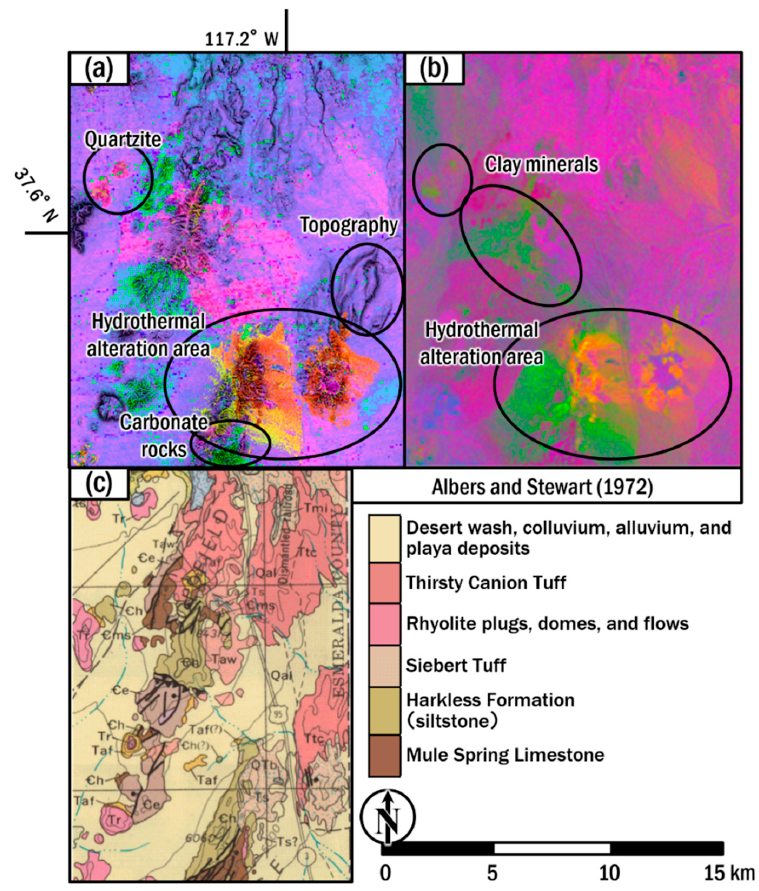
Figure 10. Images showing the zonal structures of the hydrothermal alteration generated by: ( a ) The method proposed in this paper; ( b ) The RGB color composite method with the R, G, and B primitives representing the kaolinite group index, the AlOH group content, and the FeOH group content, respectively, as developed by Cudahy [34]. ( c ) Geological map of this area [35].